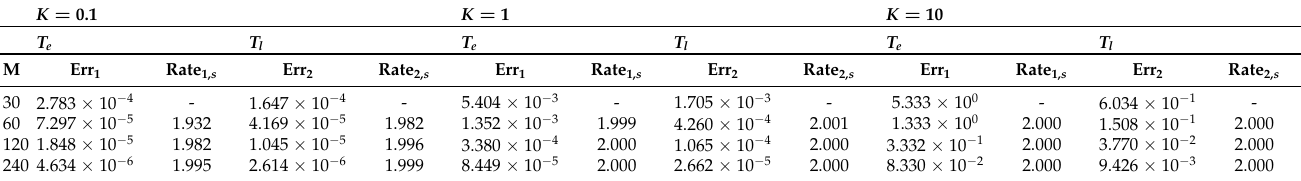
Table 4. Spatial convergence rate when N = 1000 and ( α , β ) = ( 0.3,0.2 ) for Example 1.